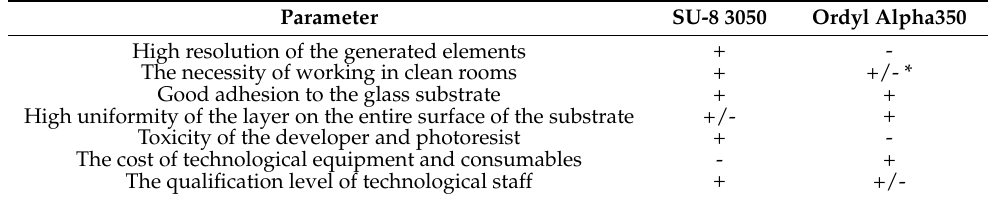
Table 3. Comparison of parameters of the microfluidic channels formed using SU-8 3050 and Ordyl Alpha 350